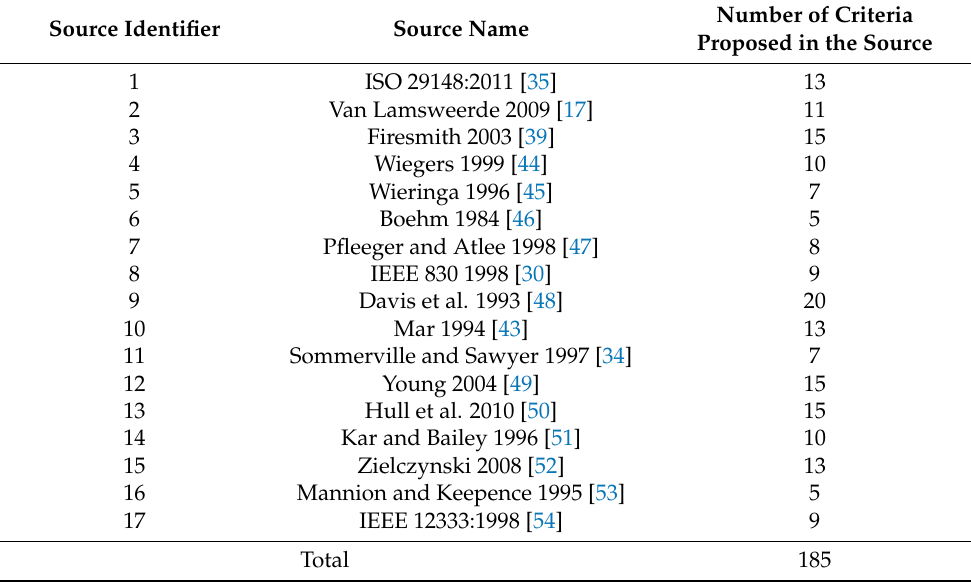
Table 1. Quality Criteria—consolidated sources